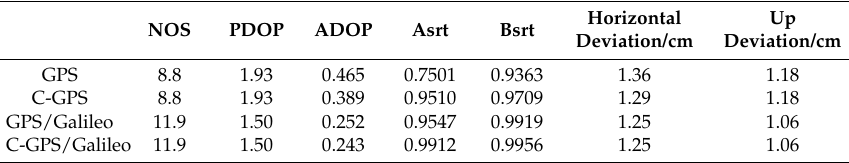
Table 3. NOS, PDOP, ADOP, success rate and position deviation of different strategies for baseline